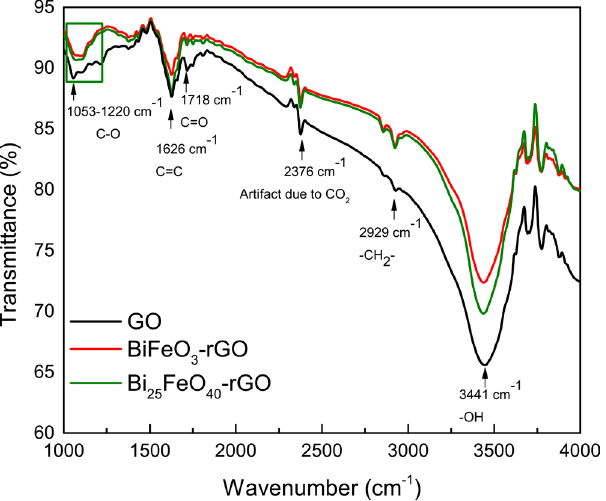
Figure 3. FTIR spectra of GO, BiFeO 3 -rGO nanocomposite, and Bi 25 FeO 40 -rGO